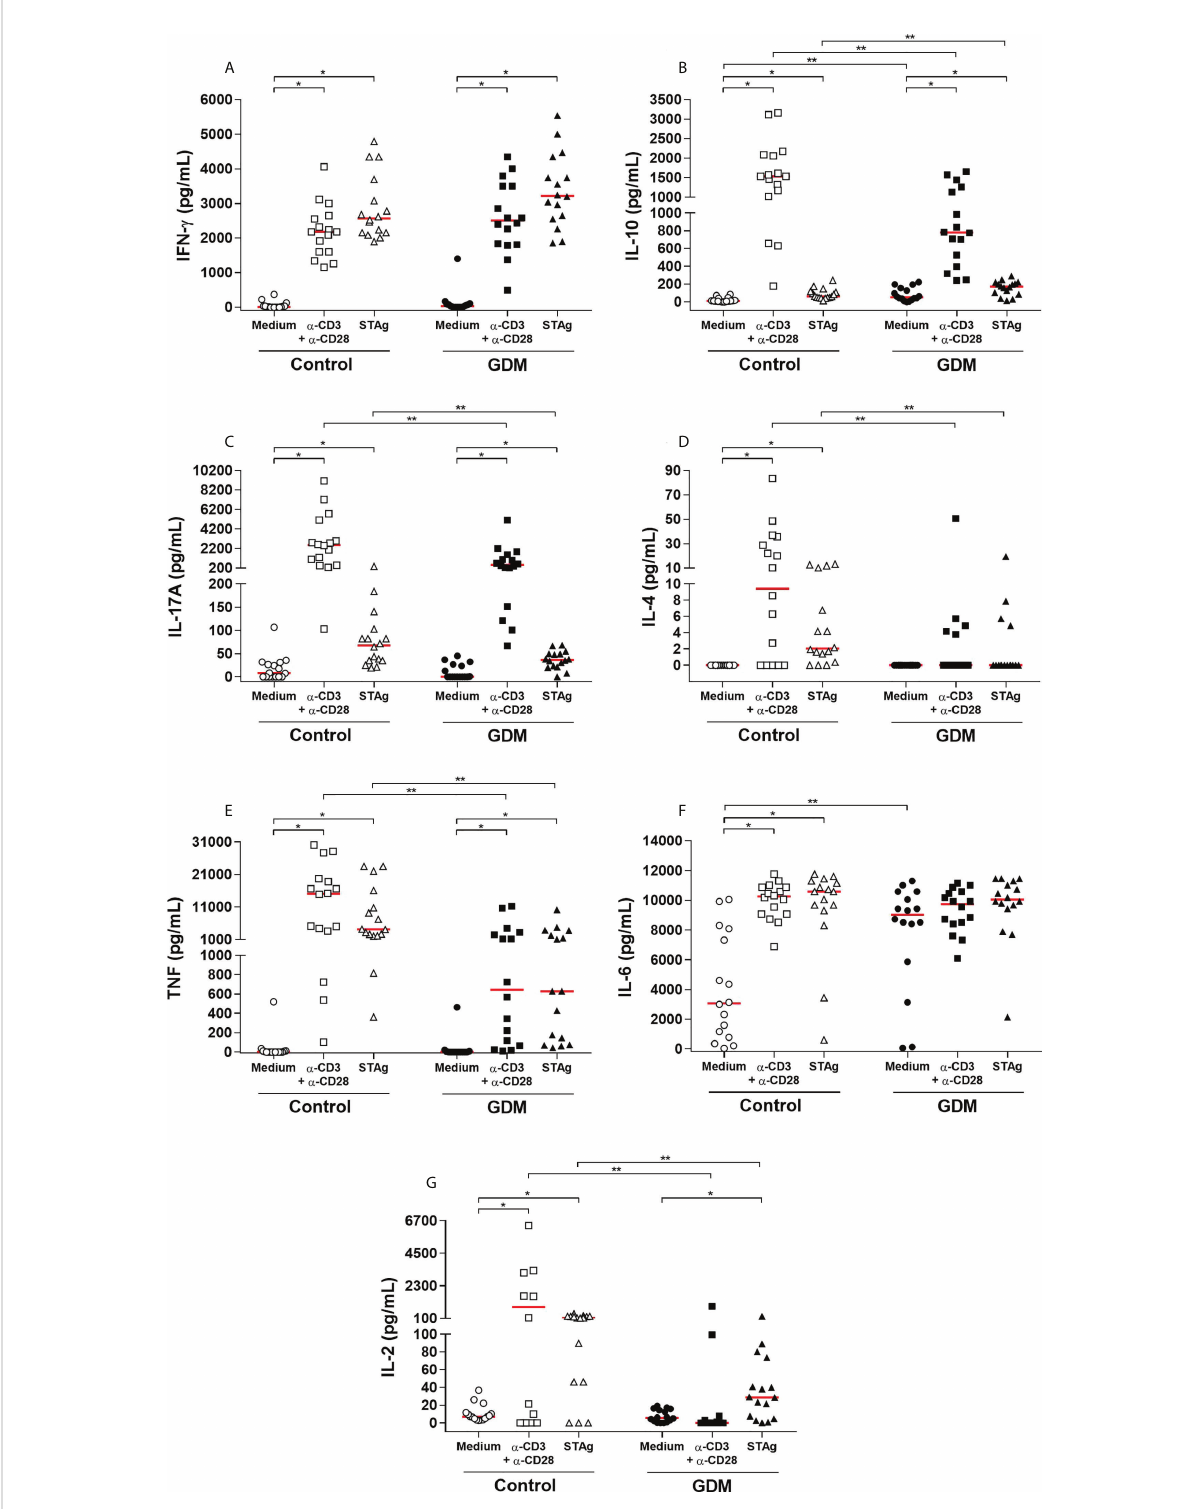
FIGURE 6 Levels of cytokines (A) IFN- g , (B) IL-10, (C) IL-17, (D) IL-4, (E) TNF, (F) IL-6 and (G) IL -2, expressed in pg/mL, which were quanti fi ed by CBA in the supernatant of the three conditions of 96 hours of culture (medium, polyclonal a -CD3/ a -CD28 stimulus and speci fi c STAg stimulus) of PBMC cells from 32 pregnant women (16 GDM and 16 controls). The red line represents the median of the values. Statistically signi fi cant data, p < 0.05 *Wilcoxon **Mann-Whitney U test. GDM, Gestational diabetes